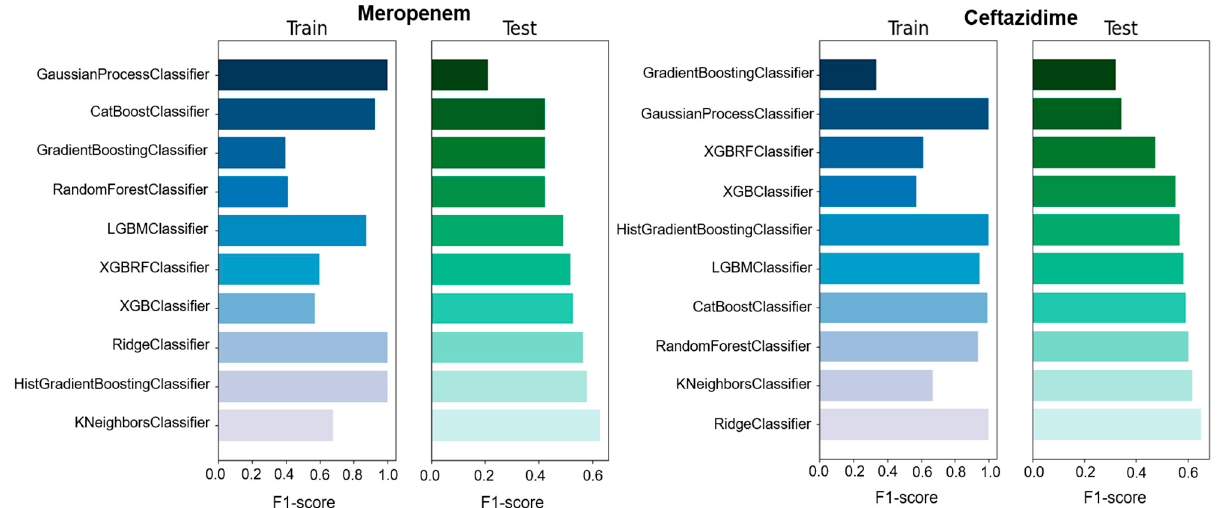
Figure 2. The comparison of F1-score of ten classification models used for gene expression prediction